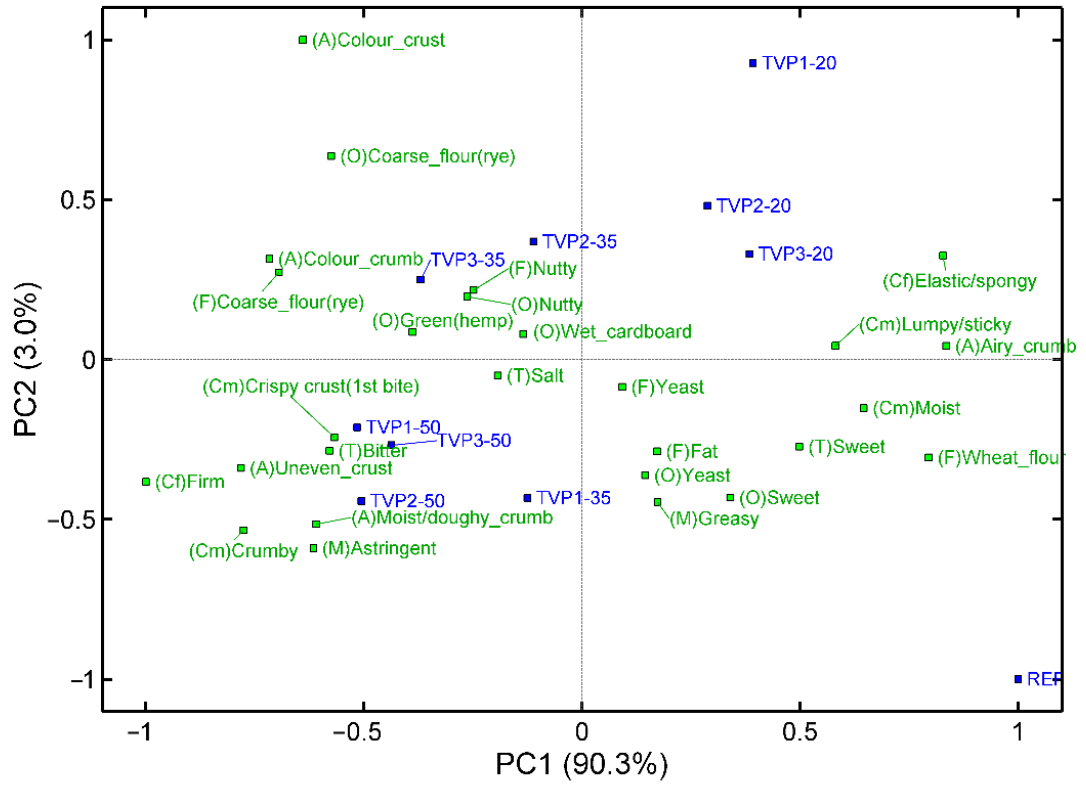
Figure 1. PCA biplot for the sensory profile of all buns. REF: Reference sample with 0% added TVP; TVP1: extrudate with 10% faba bean, 89% pea, 1% salt; TVP2: extrudate with 49% faba bean, 40% pea, 10% quinoa, 1% salt; TVP3: extrudate with 10% faba bean, 79% pea, 10% hemp, 1% salt; 20: 20% addition; 35: 35% addition; 50: 50% addition. A: appearance, O: odour, F: flavour, T: taste, Cf: con- sistency with fingers, Cm: consistency in mouth, and M: mouthfeel.